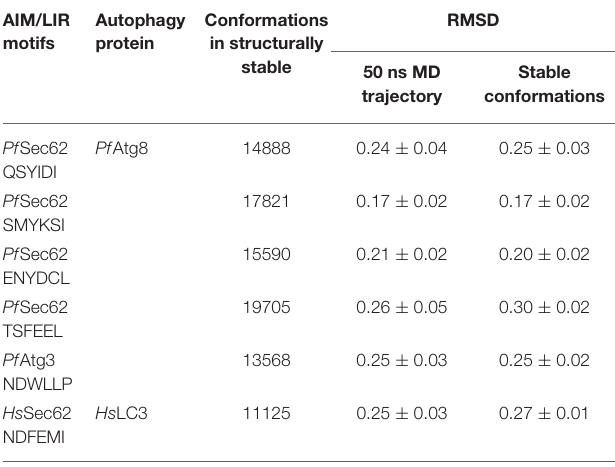
TABLE 1 | Conformations obtained from structurally stable states and the